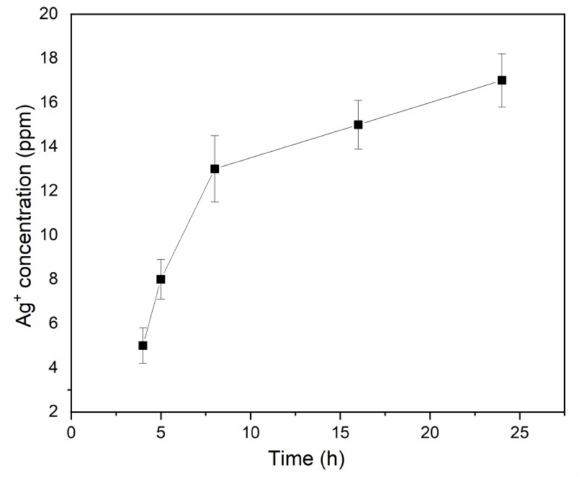
Figure 11. Ionic release of Ag + from the nanofibrous scaffolds of PCL containing modified HAP at the concentration of 0.8 Ag/V-HAP@PCL.